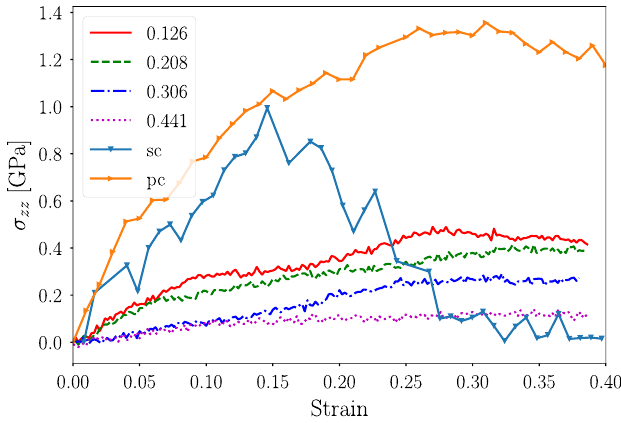
Figure 3. σ zz vs. effective